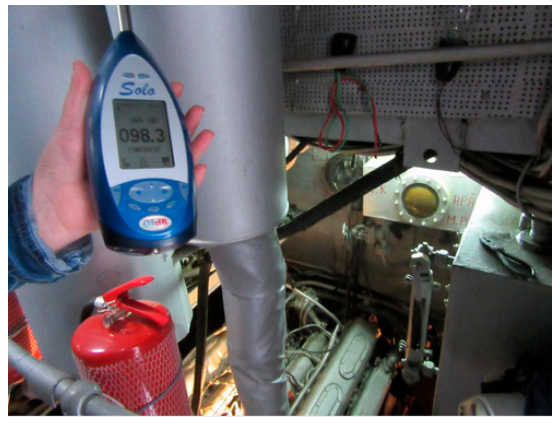
Figure 5. The sonometer BlueSolo 01 dB.